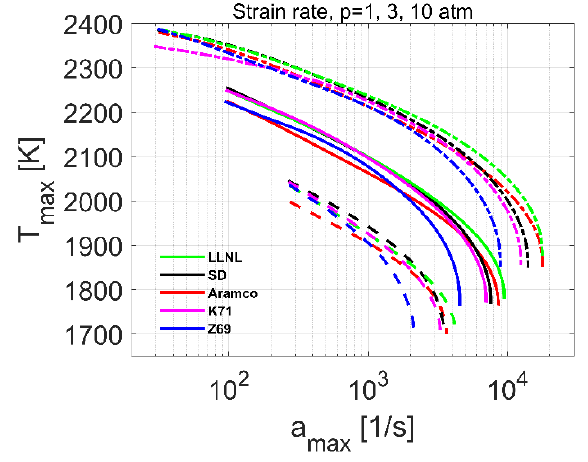
Figure 8. Extinction strain rates for DME-air mixtures at 1 atm, solid line, 3 atm, dashed line, and 10 atm, dot-dashed line. Legend: Mechanism predictions from Z69 in blue, LLNL in green [28], Aramco in red [17], K71 in magenta [32] and San Diego in black [30].